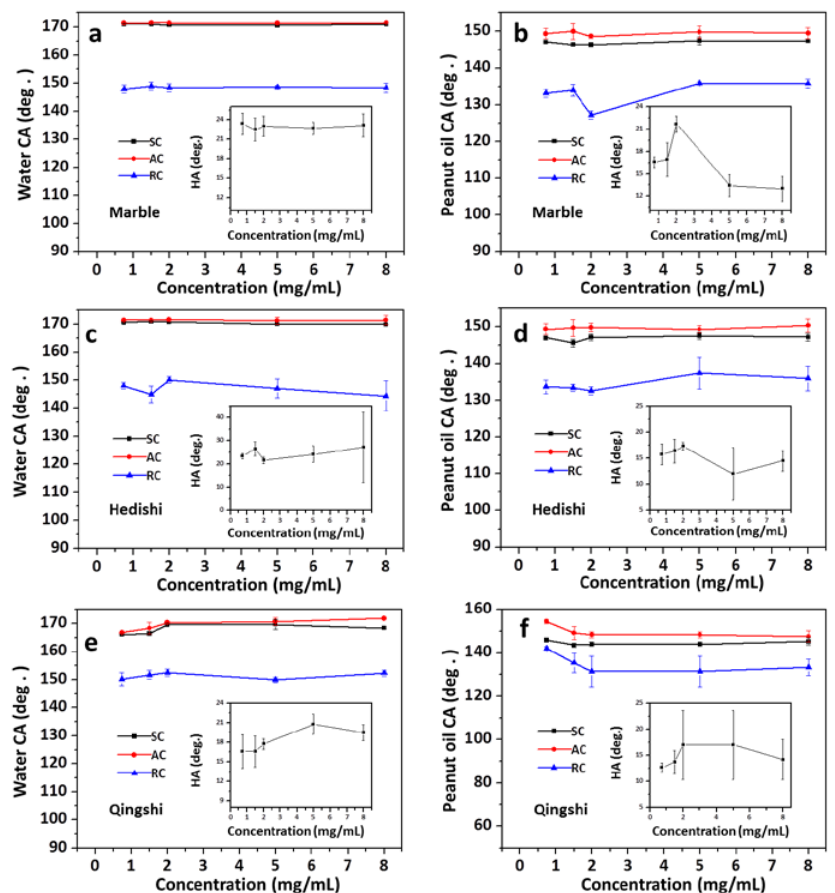
Figure 2. Static, advancing, and receding contact angles of water (represented as SC, AC, and RC, respectively) ( a , c , e ) and peanut oil ( b , d , f ) on marble, Hedishi, and Qingshi as a function concentra- tion of dopamine polymerized on the stones as the adhesive layer, on which the concentration of Al 2 O 3 @FPA used to render the surface hydrophobic had a concentration 1.0 mg/mL, respectively. Inserted in the figures are the hysteric angles (HAs), that is, the difference between the advancing and receding contact